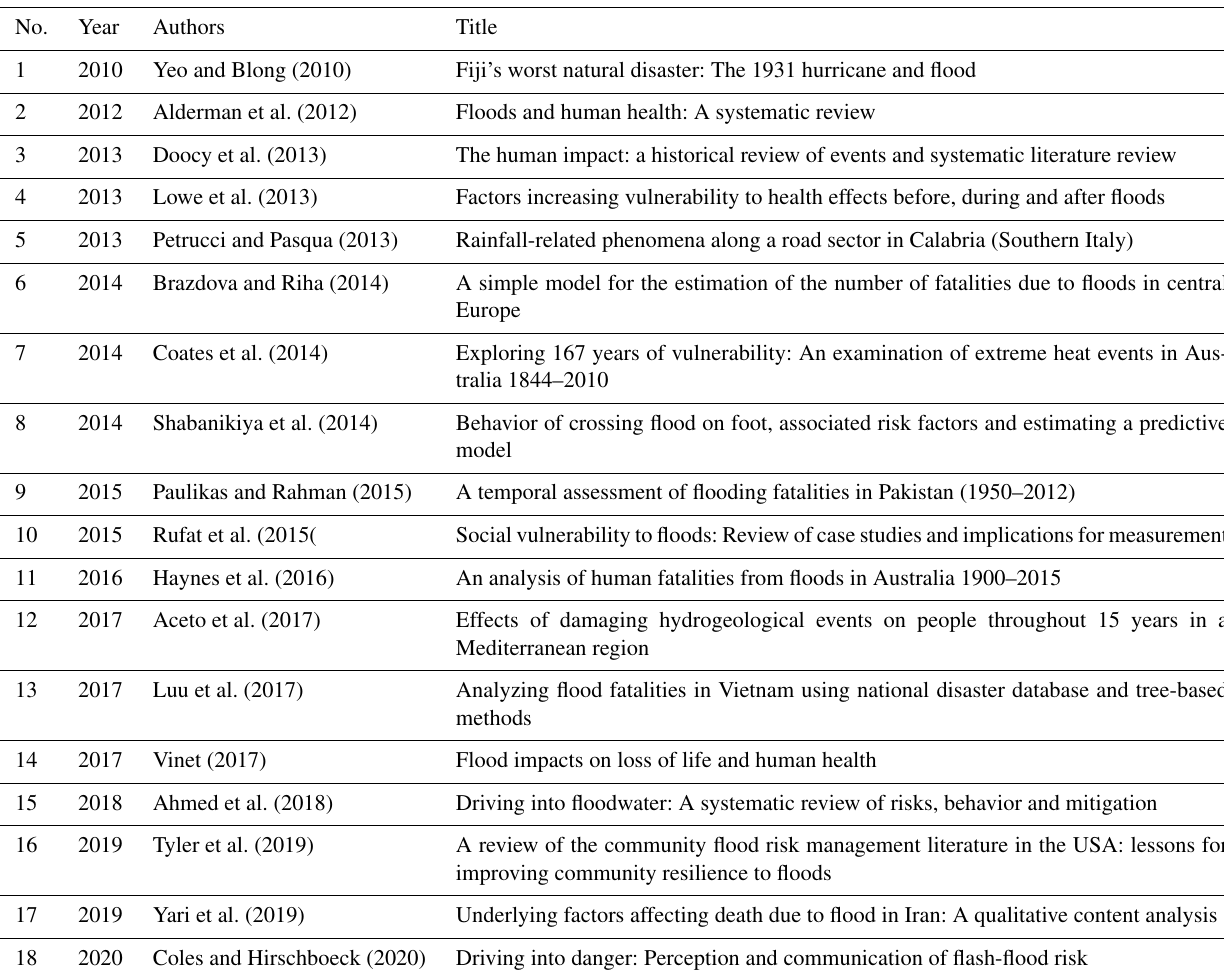
Table 2. Articles quoted in the text as supportive material (in chronological order of publication).